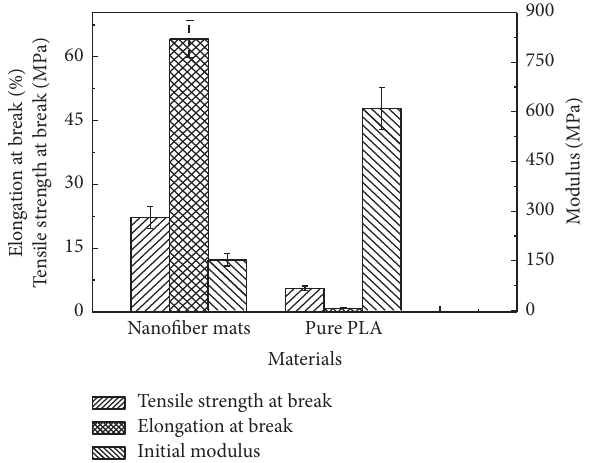
Figure 5: Mechanical properties of nanofiber mats and pure